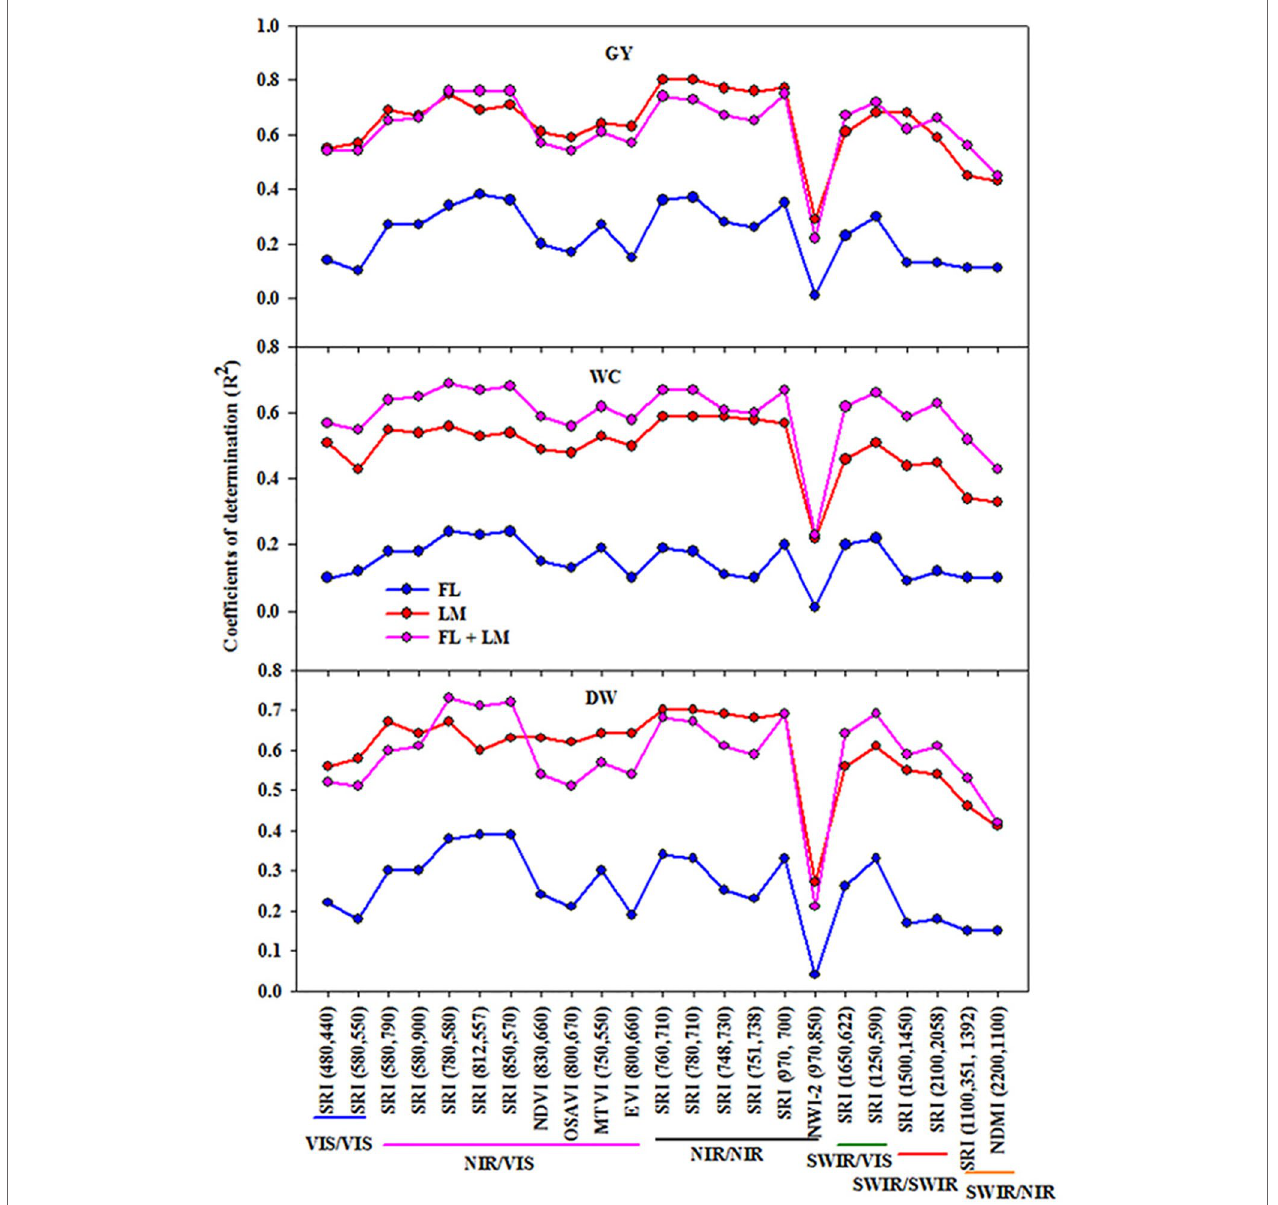
FIgURe 2 | Coefficient of determinations (R 2 ) for the linear relationships of different spectral reflectance indices with shoot dry weight per square meter (DW), water content of aboveground biomass (WC), and grain yield per hectare (GY) under full irrigation (FL), limited irrigation (LM) (n = 192), and the combined two treatments (FL+LM) (n = 384). R 2 values ≥ 0.10 are significant at alpha = 0.05.